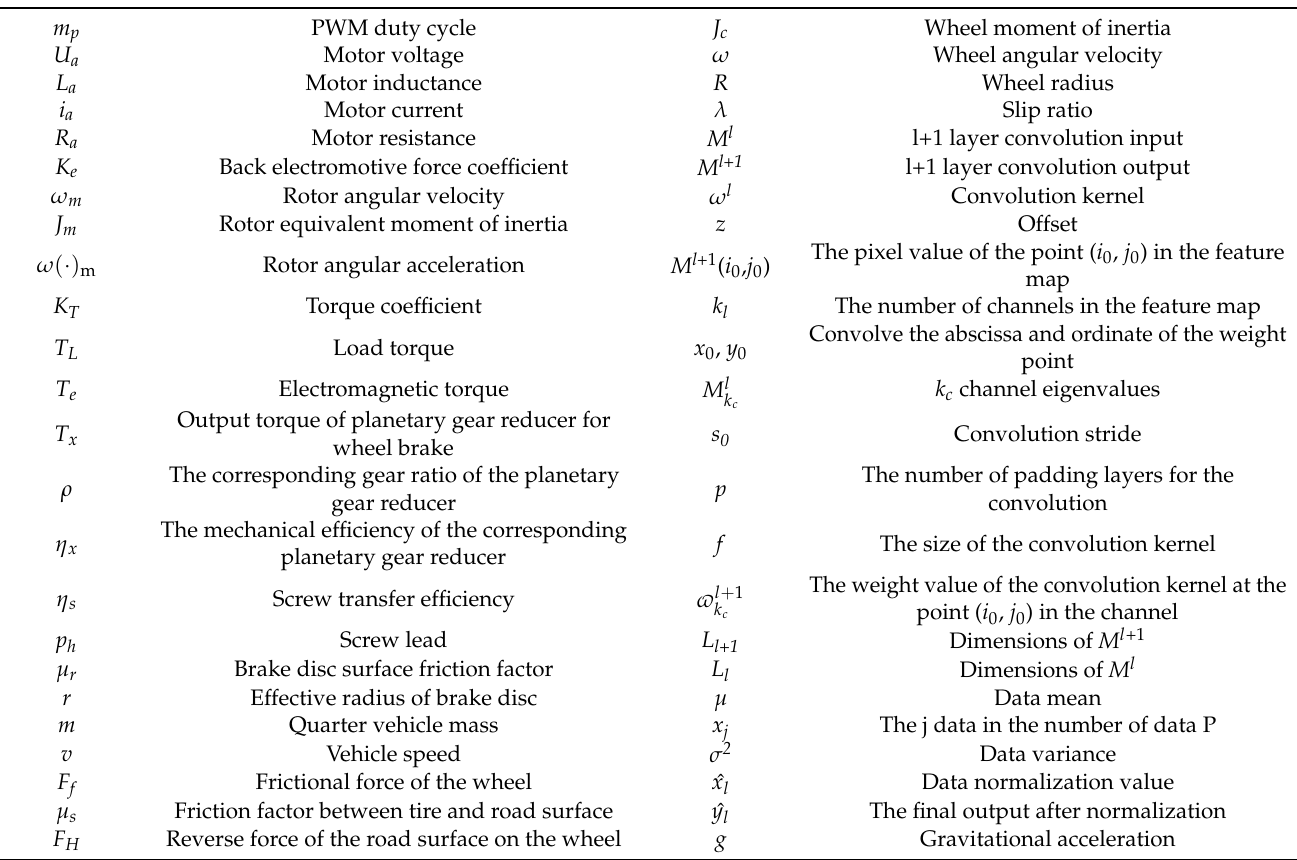
Table 1. List of variable definitions.